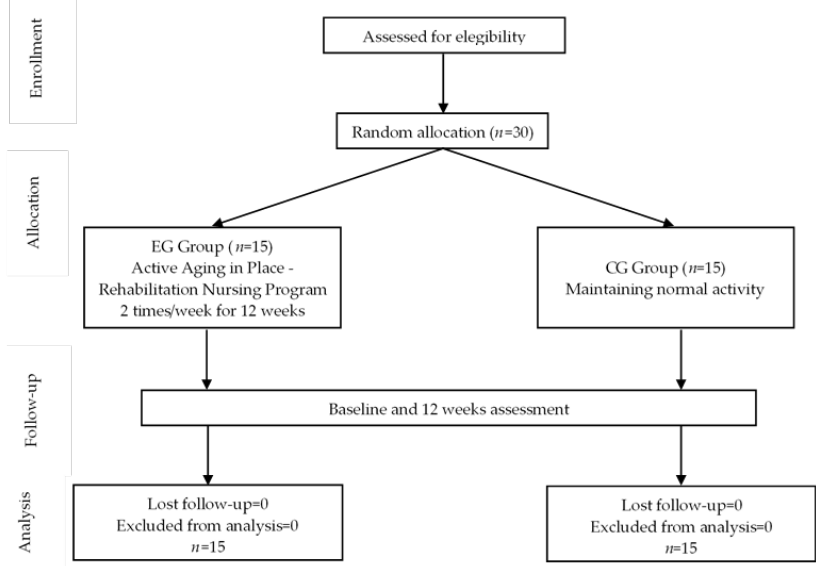
Figure 1. CONSORT flow diagram of participants’ flow through study.